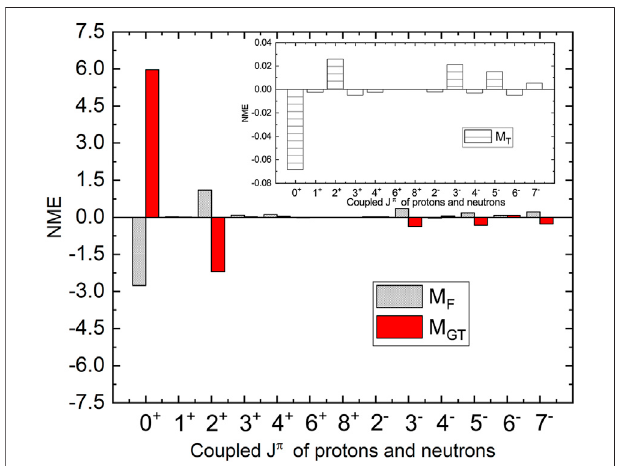
FIGURE 1 | (Color online) Variation of M F , M GT , and M T type NMEs with J π of two initial neutron-neutron and fi nal proton-proton pairs.